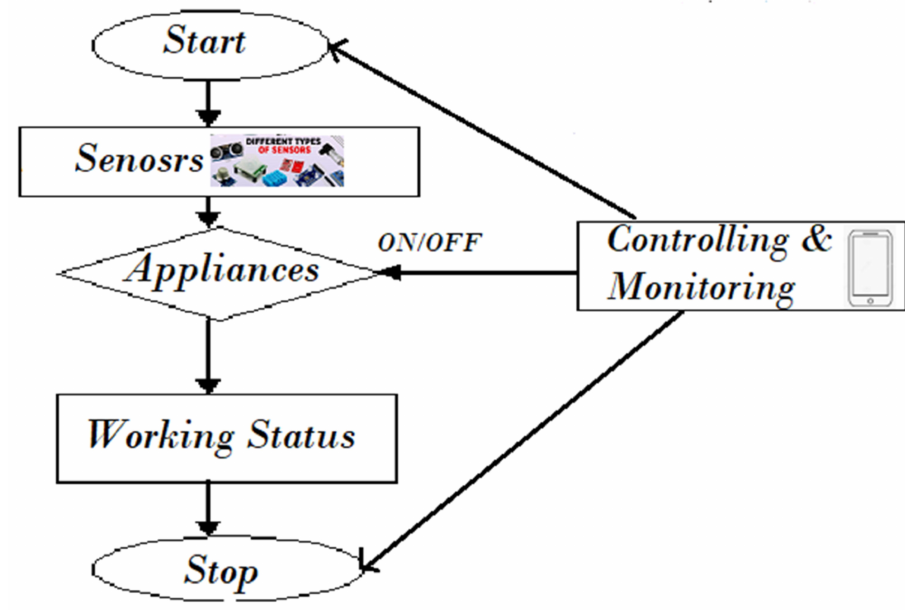
Figure 4. Working system controlled through a mobile